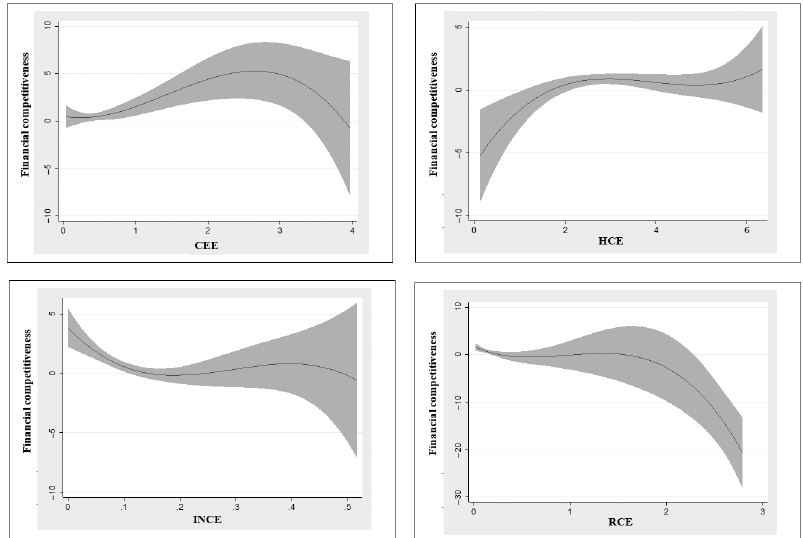
Figure 2. The cubic relationship between IC components and